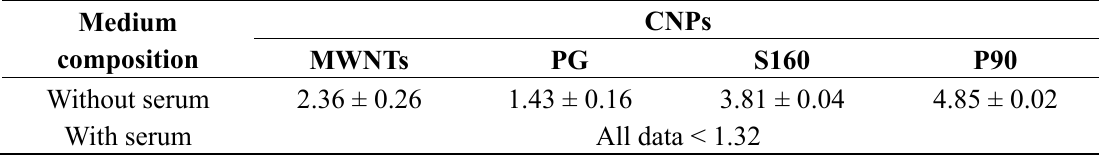
Table 1. The amounts of phenol red adsorbed on CNPs (µg mg − 1 ). All data shown are based on three independent